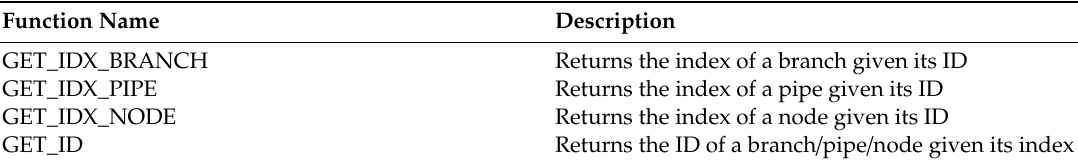
Table 3. Description of Get Index / ID Functions.